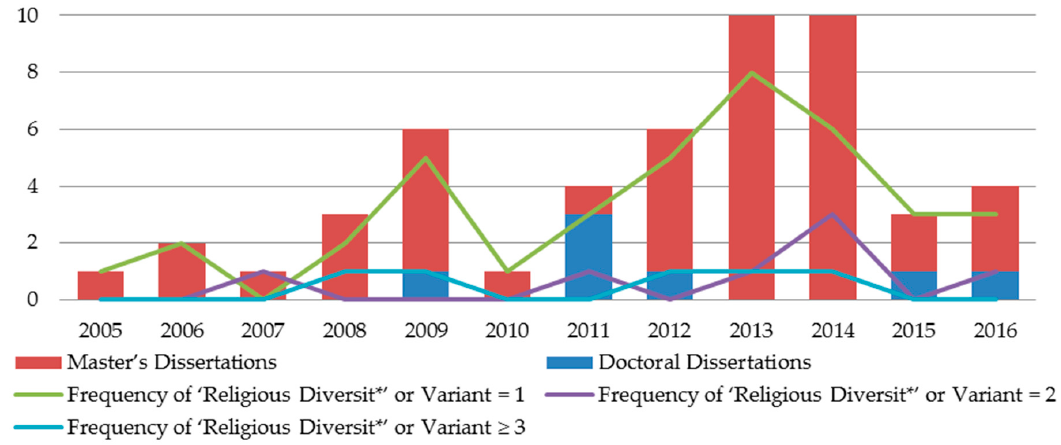
Figure 1. Frequency of the English Phrase ‘Religious Diversity’ in Chinese Dissertations (2005–2016).